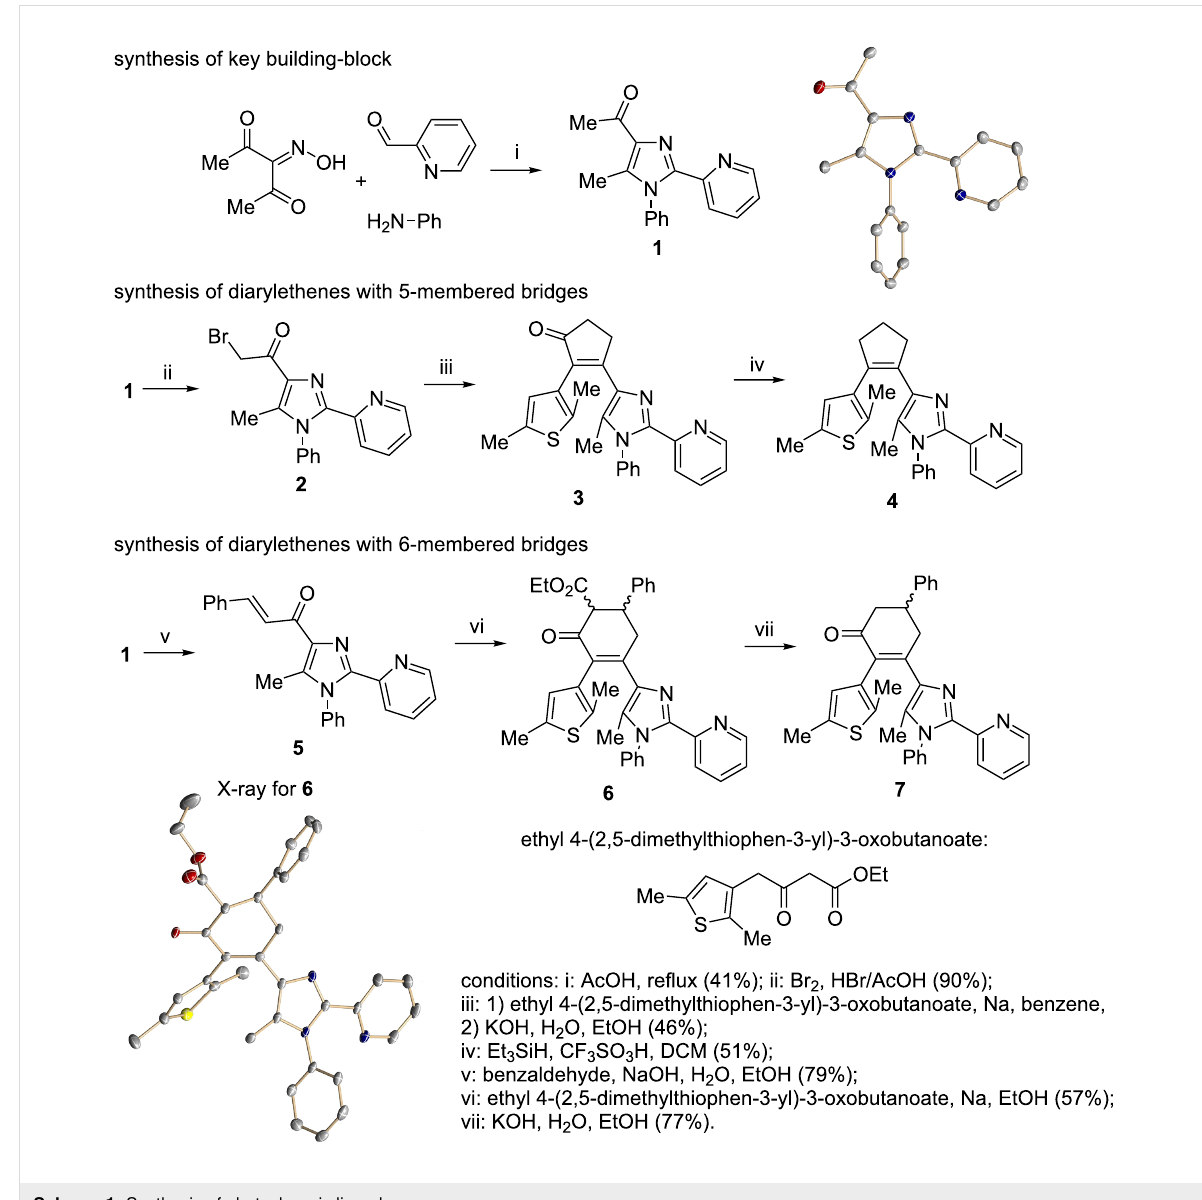
Scheme 1: Synthesis of photochromic